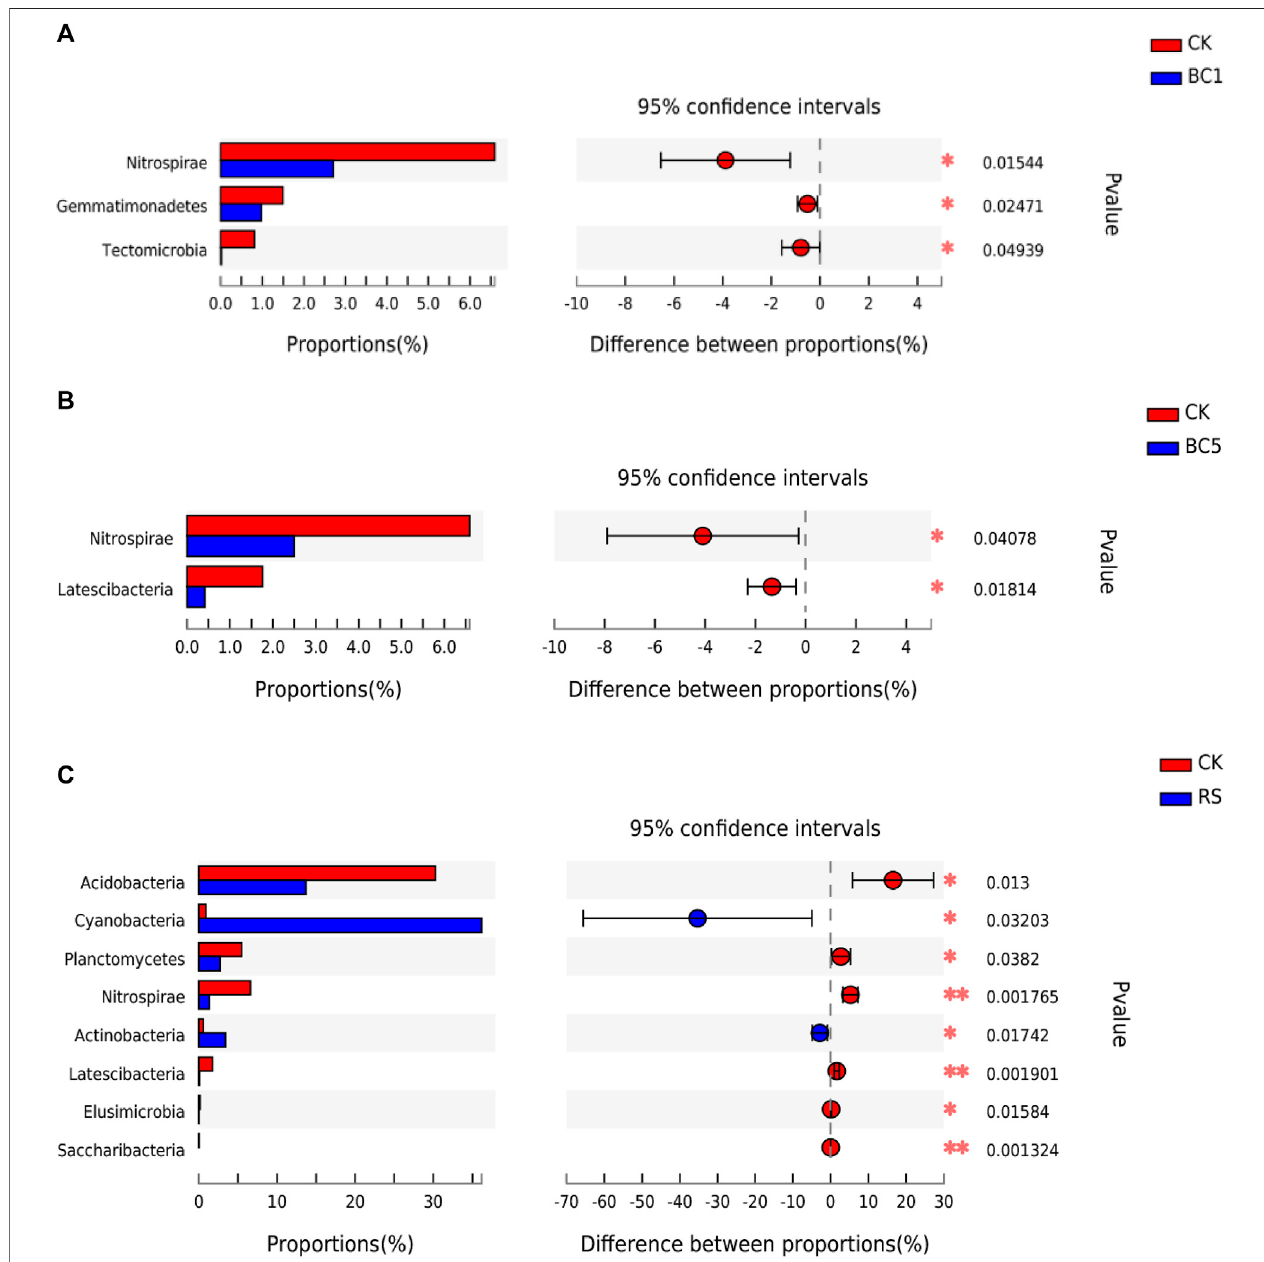
FIGURE 4 | Soil bacterial phyla with signi fi cant differences among CK and BC1 (A) , BC5 (B) , and RS (C) . CK: without biochar or rice straw; BC1: 2.25 Mgha − 1 biochar; BC5: 11.25 Mgha − 1 biochar; RS: 2.25 Mgha − 1 rice straw. **p < 0.01 and *p < 0.05.